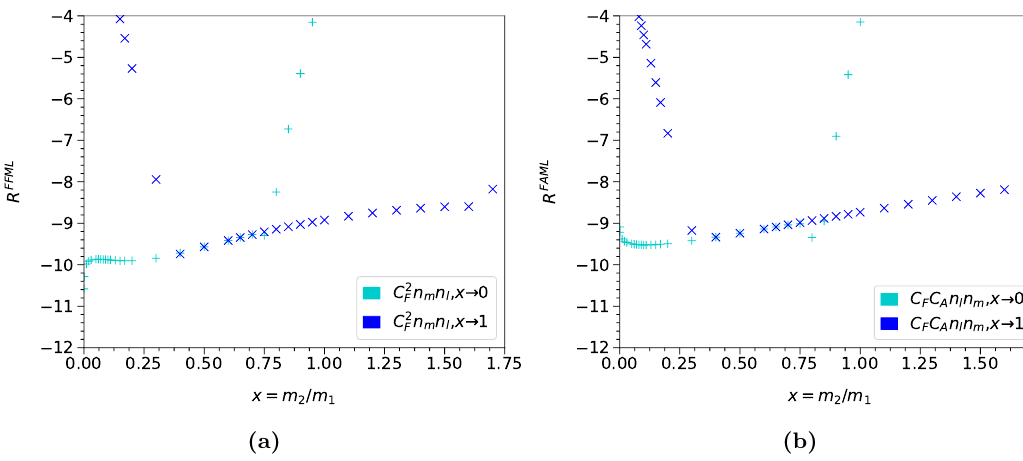
Figure 4 . Relative uncertainty of bare result for the colour structures C 2 (b). See the text for details.